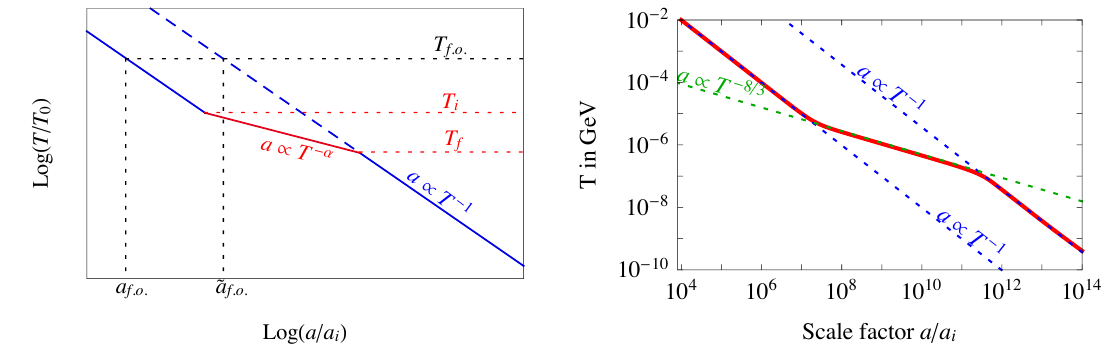
Figure 2 . Left: sketch of the non-standard a p T q scaling. Values of (cid:11) ¡ 1 in eq. (3.8) imply a scale factor at freeze-out, a f:o: , smaller than the one obtained from a standard cosmology, ~ a f:o: . This in turn leads to a suppression of the relic density by a factor p a f:o: { ~ a f:o: q 3 (cid:16) p T f { T i q 3 (cid:11) (cid:1) 3 . Right: scaling obtained by solving numerically (3.9) and (3.10) for M (cid:16) 100 TeV and T dc (cid:16) (cid:3) DC (cid:16) 10 GeV. Q There exists an epoch during which the a p T q scaling is very well approximated by a power law a _ T (cid:1) (cid:11) with (cid:11) (cid:16) 8 {